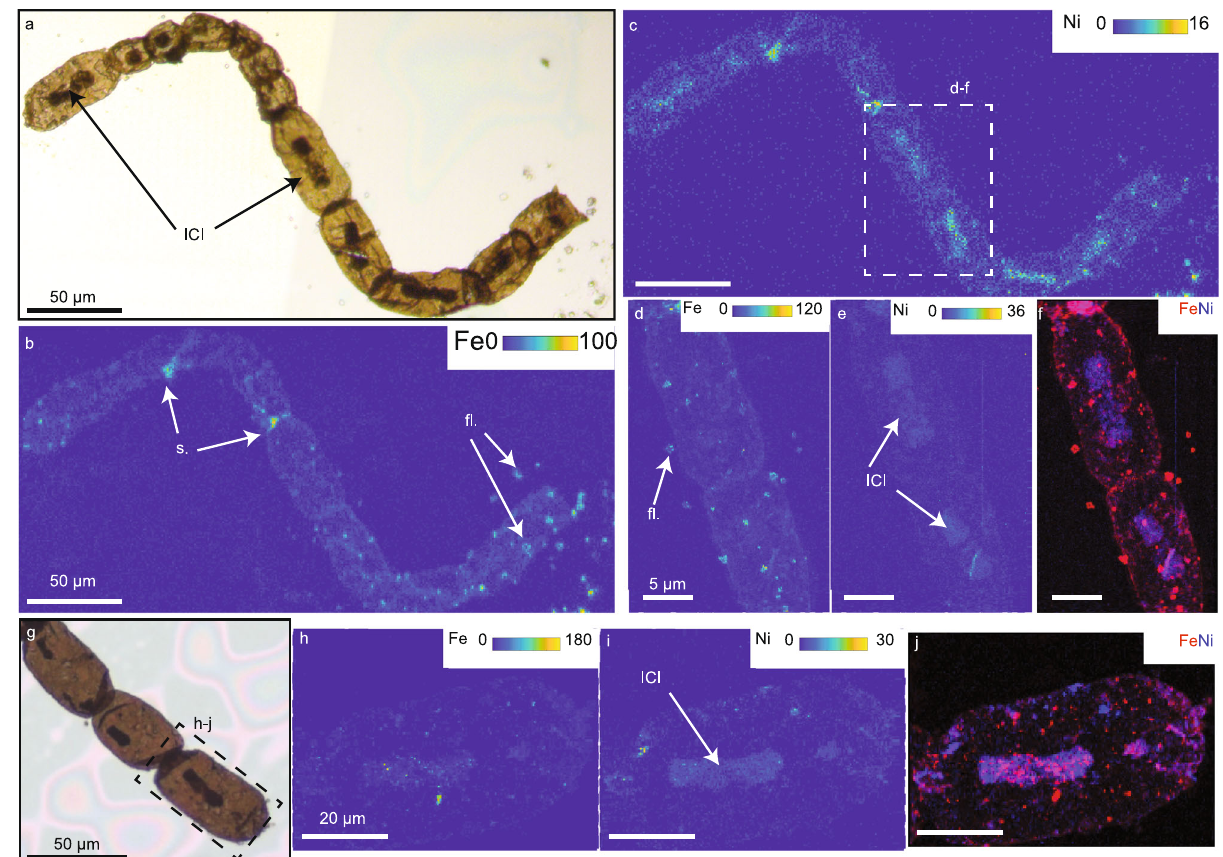
Fig. 2 Nickel-speci fi c enrichment in intracellular inclusions. a , g Microphotographs of the studied specimen. b – f Fe and Ni SR- μ XRF maps obtained at SLS ( b , c pixel: 1 μ m, 200 ms/px), at SS ( d , e pixel: 400 nm, 100 ms/px) and, the associate composite image ( f , R: Fe, B: Ni). These maps show a speci fi c enrichment of Ni uncorrelated of Fe in the intracellular inclusions (ICI) while the walls appear homogeneously enriched in Fe and Ni. h – j Fe and Ni SR- μ XRF maps obtained at SLS ( h , i pixel: 1 μ m, 1 s/px) and the associated composite image ( j , R: Fe, B: Ni). These maps show that some ICIs can also be enriched in Fe, but that Fe is present as small hotspots in the ICI while Ni is mainly homogeneously distributed. Color scales correspond to normalized counts. (s.) is for sul fi des and ( fl .) is for fl uorides attached to the surface of the